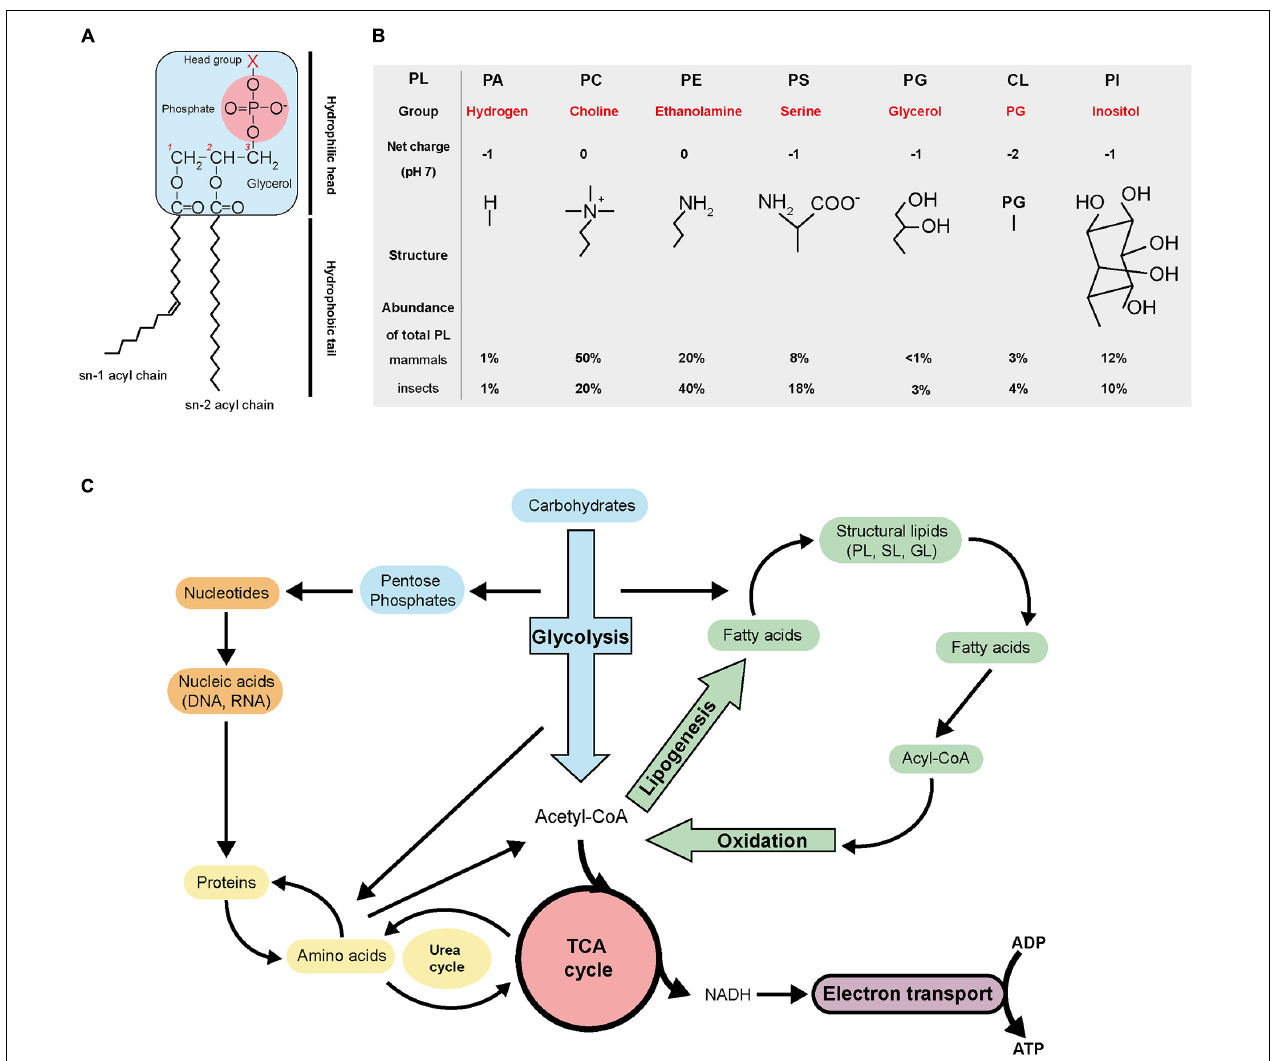
FIGURE 2 | Phospholipid structure and general metabolism. (A) Schematic of phospholipid structure. (B) Basic characteristics of the different phospholipid categories. (C) Overview of the general metabolism. PL, phospholipid; PA, phosphatidic acid; PC, phosphatidylcholine; PE, phosphatidylethanolamine; PS, phosphatidylserine; PG, phosphatidylglycerol; CL, cardiolipin; PI, phosphatidylinositol; TCA, tricarboxylic cycle; SL, sphingolipid; GL, glycerolipid; NADH, nicotinamide adenine dinucleotide; ADP, adenosine diphosphate; ATP, adenosine